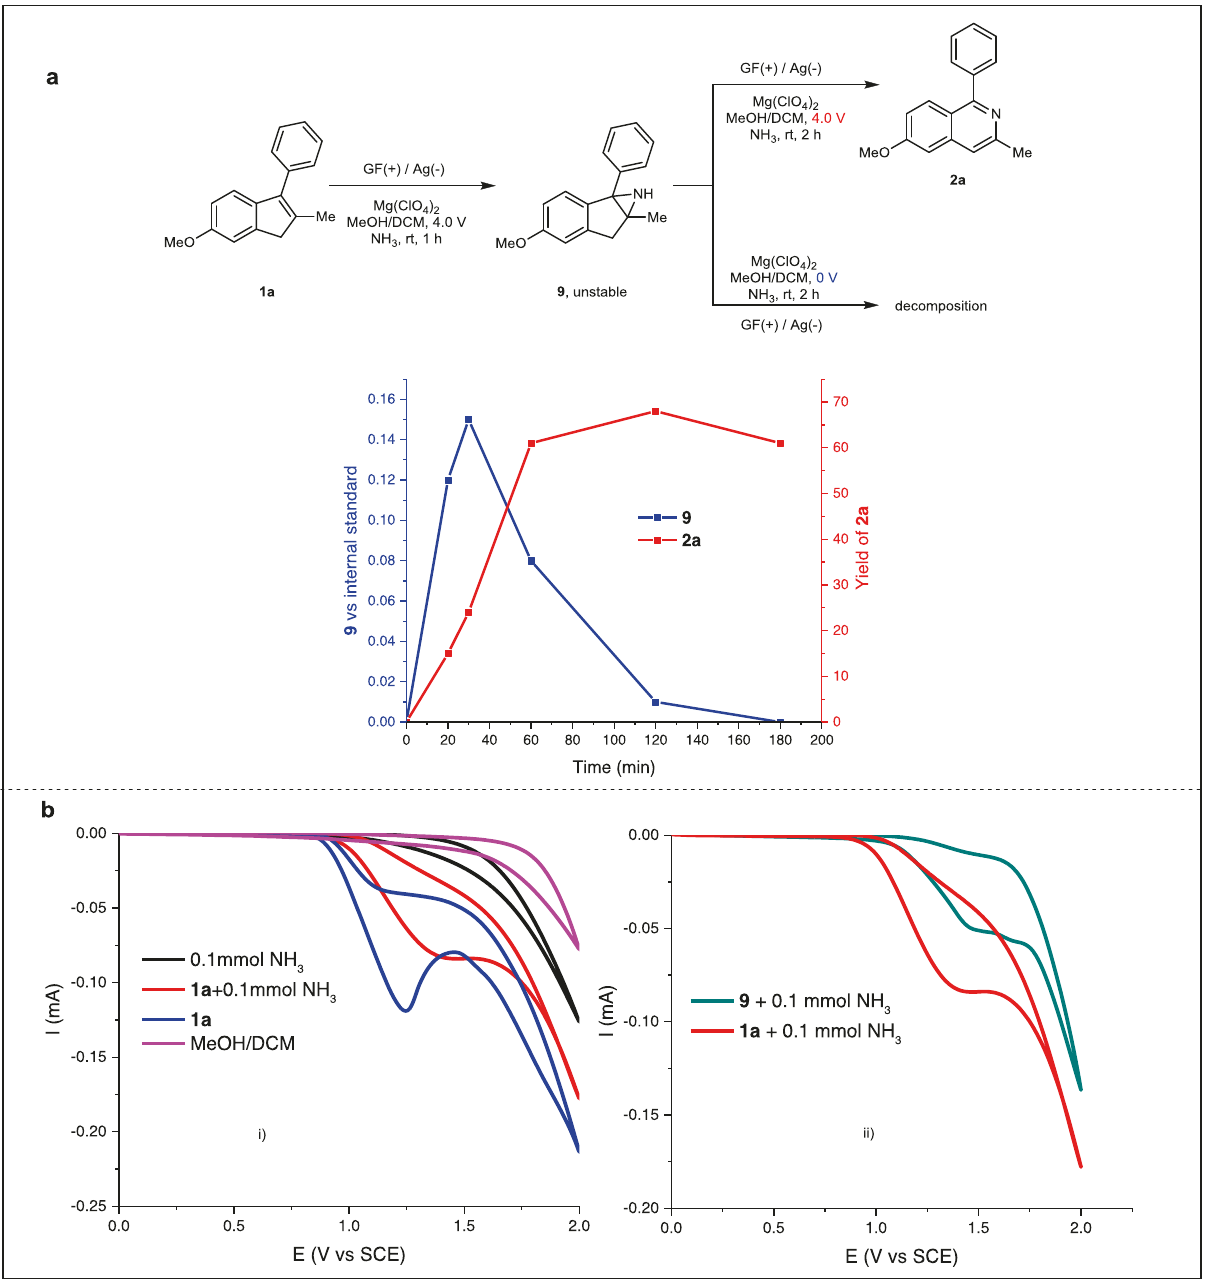
Fig. 4 Experiments investigating the reagents and intermediates. a Investigation and tracking of intermediates 9 under different conditions. b Cyclic voltammetry experiments of reactants and 9 . GF, graphite felt; DCM,